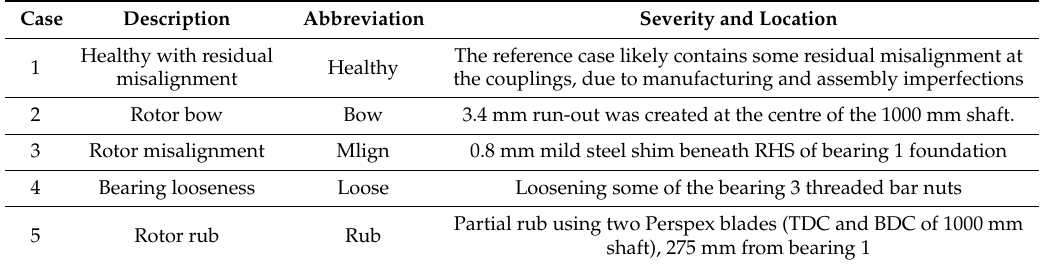
Table 1. Description of experimentally simulated cases.